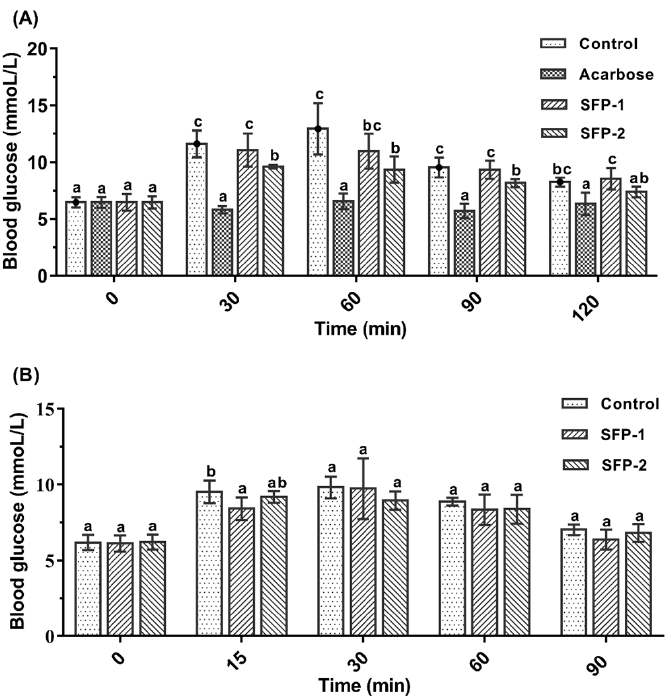
Figure 1. Effects of SFPs on blood glucose after starch loading ( A ) and glucose loading ( B ) in rats. The different letters represent significant differences ( p < 0.05).